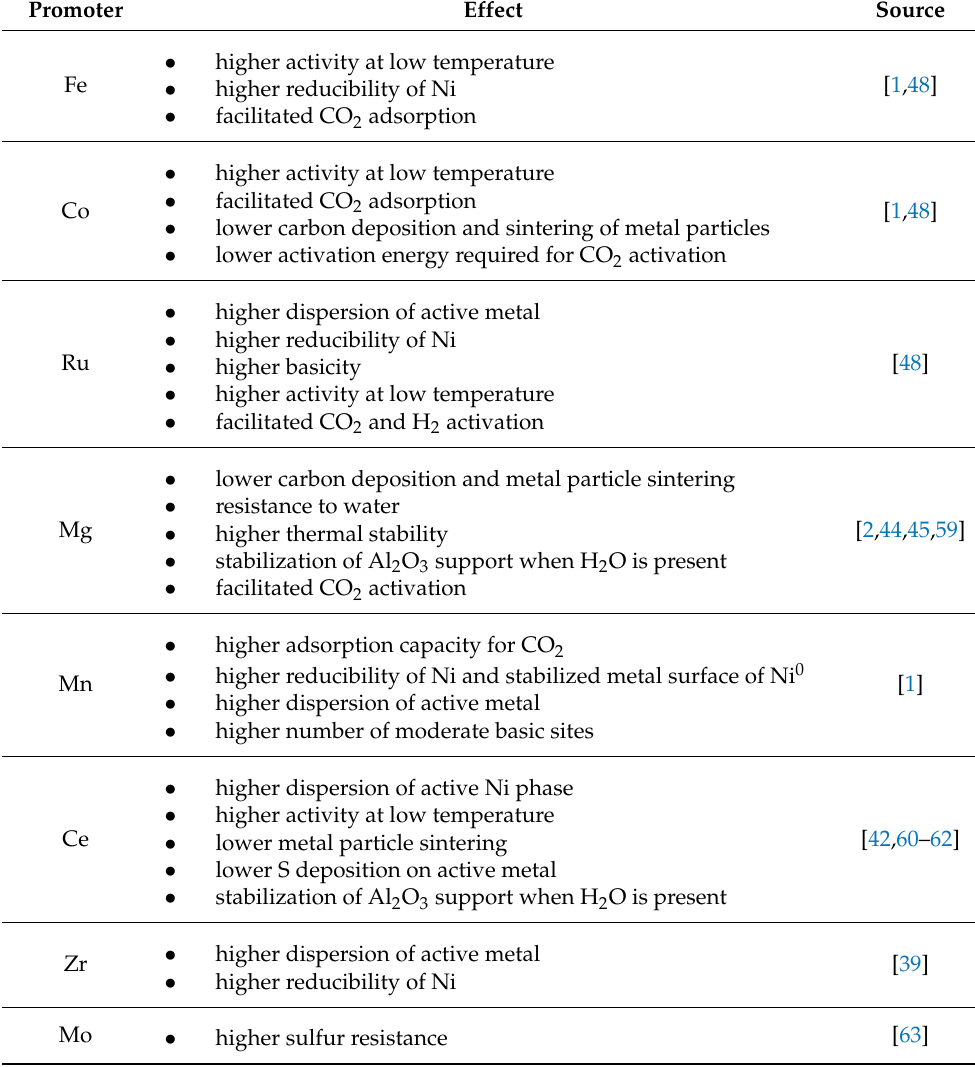
Table 2. Common promoters used in catalysts for CO 2 methanation and their